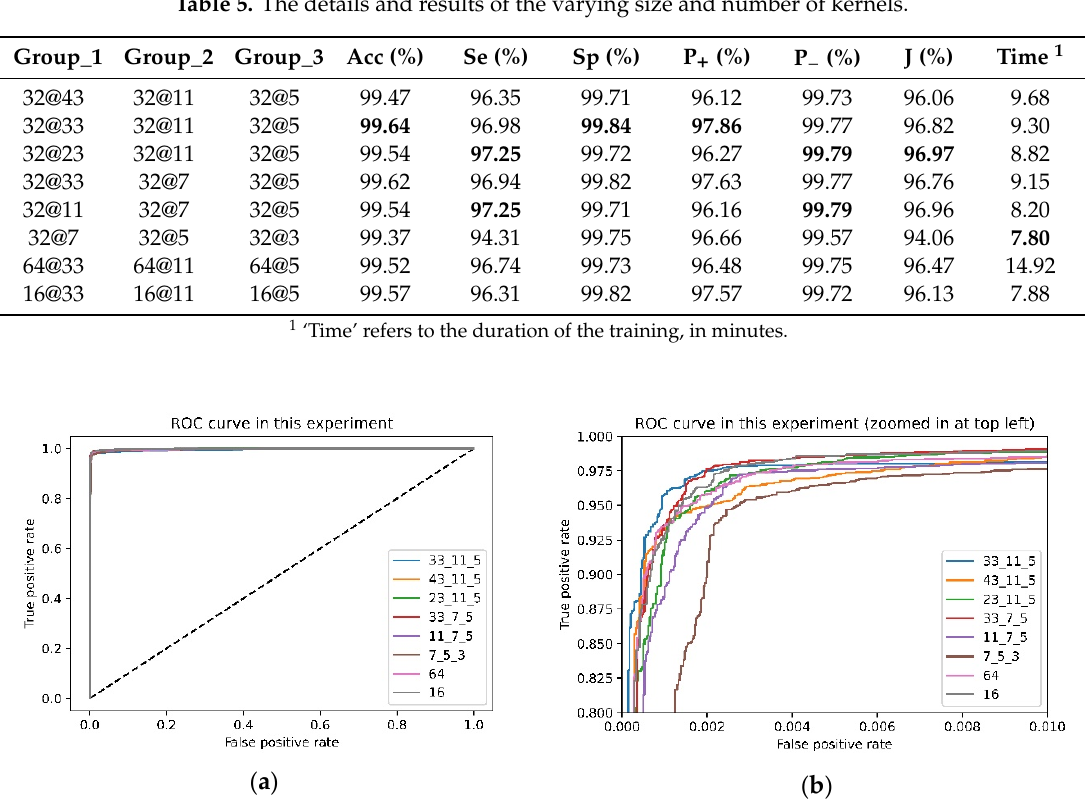
Table 5. The details and results of the varying size and number of kernels.